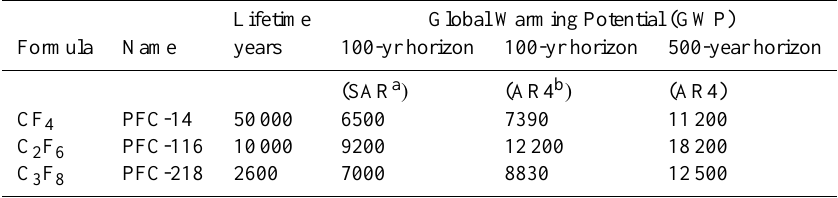
Table 1. Lifetimes and global warming potentials of CF 4 , C 2 F 6 , and C 3 F 8